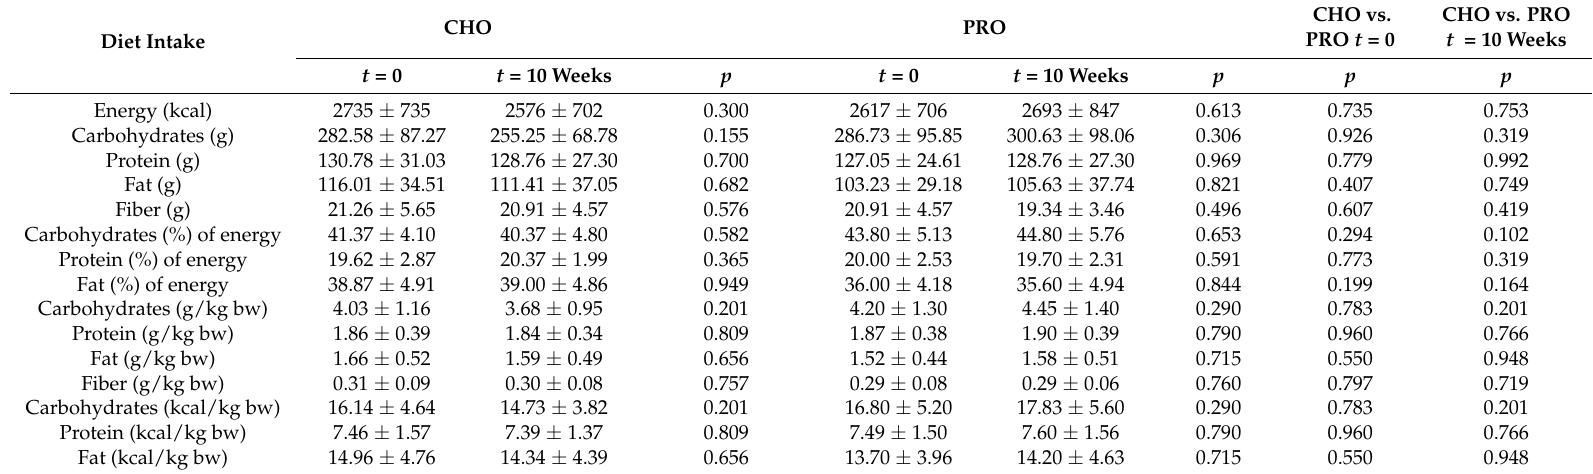
Table 4. Nutrient intake per day without nutritional